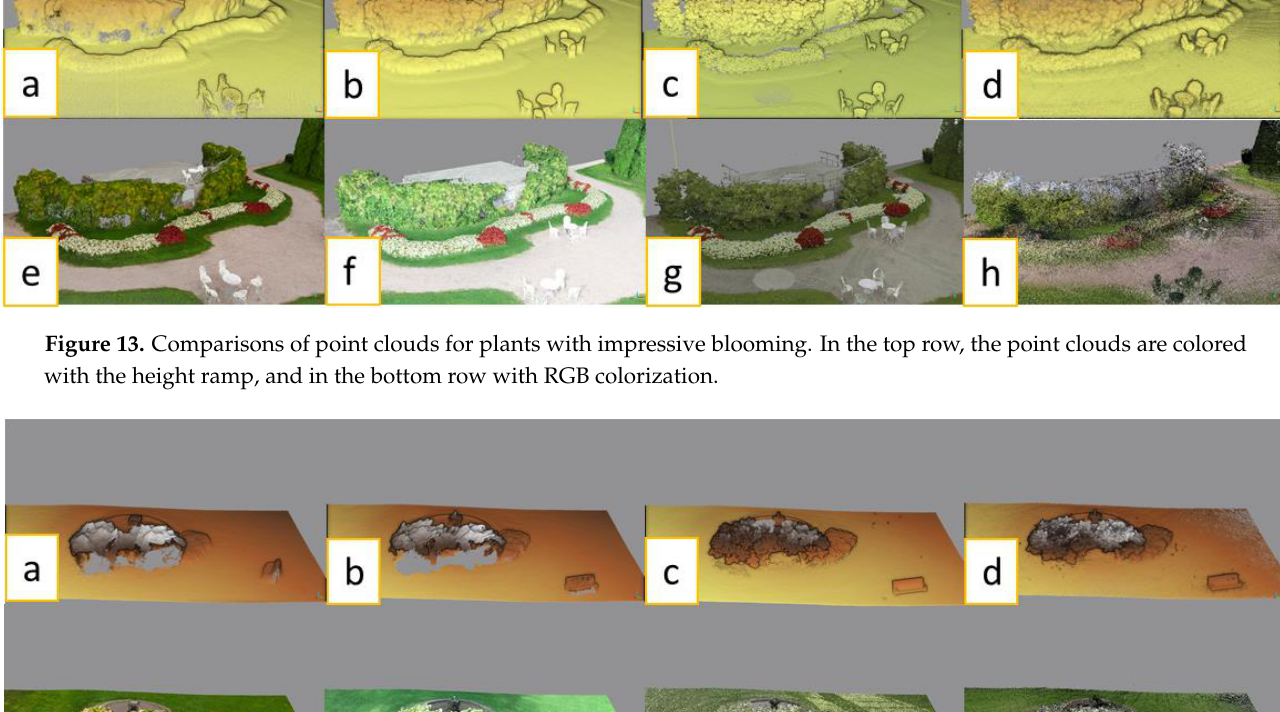
Figure 13. Comparisons of point clouds for plants with impressive blooming. In the top row, the point clouds are colored with the height ramp, and in the bottom row with RGB colorization.